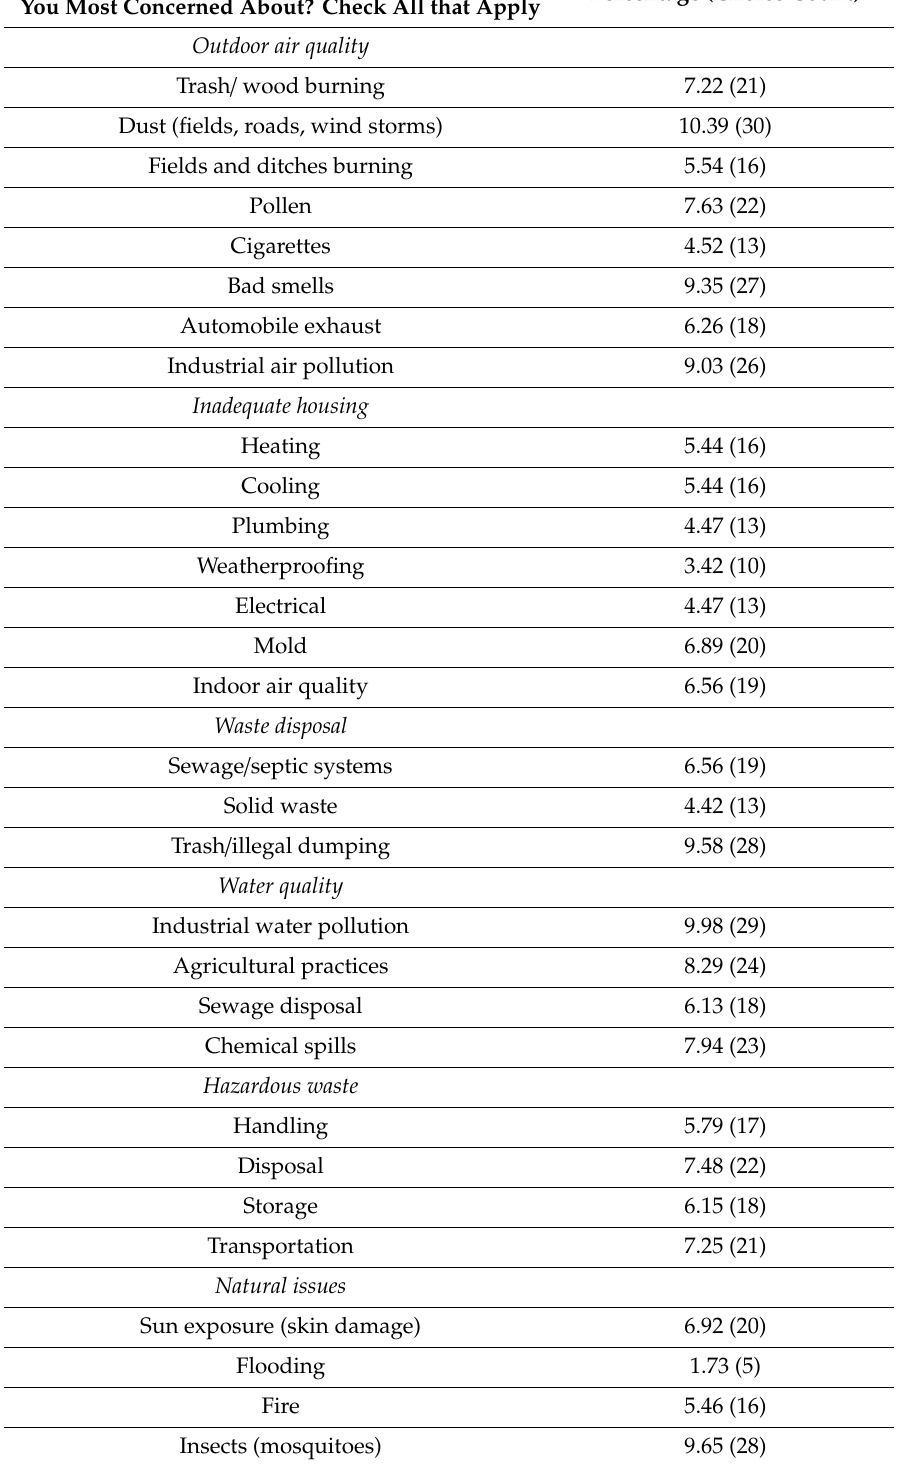
Table A2. Survey question on environmental issues of concern for residents of Kettleman City. Which of the Following Environmental Issues are You Most Concerned About? Check All that